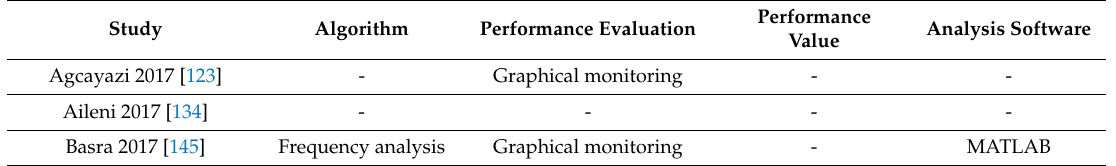
Table A4. Analysis of the processing algorithm, performance evaluation, and software for the studies of the wearable category published before